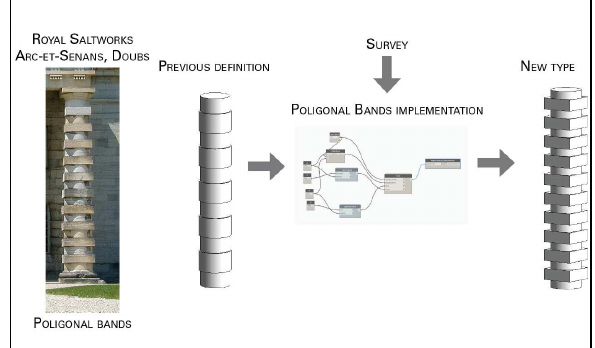
Figure 11. Polygonal bands implementation